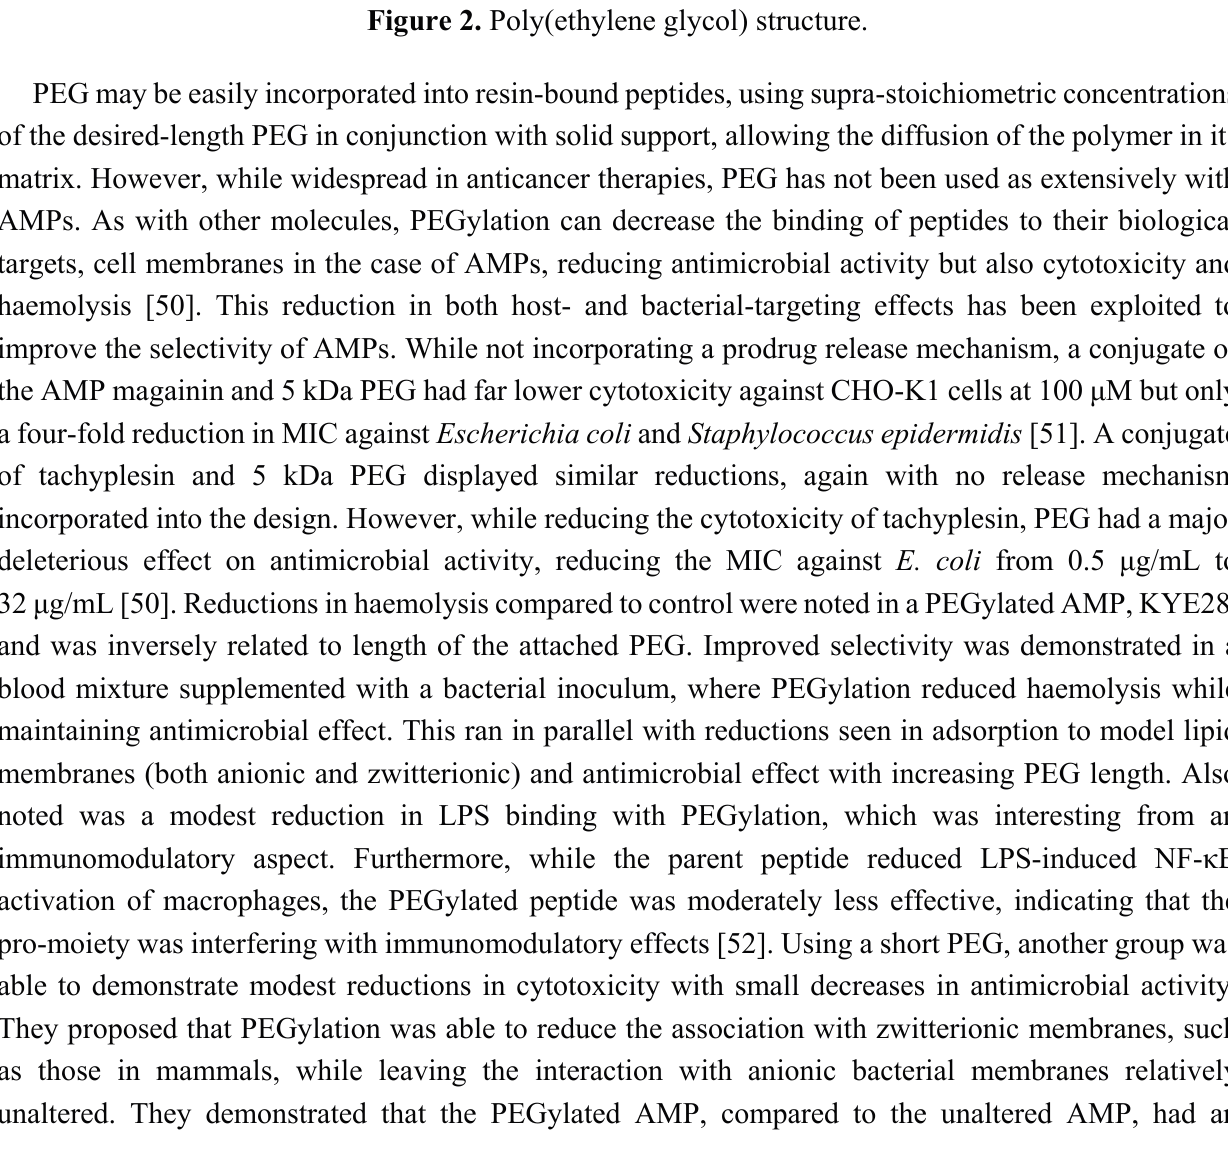
Figure 2. Poly(ethylene glycol)